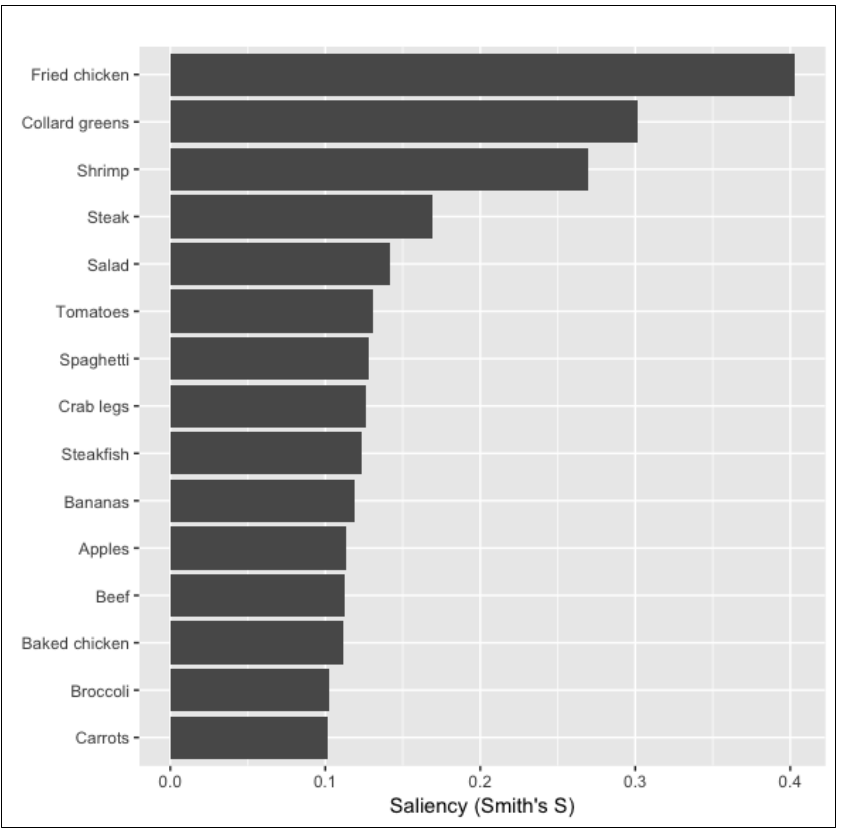
Figure 1. Saliency of Food Items with the Highest Smith’s S Salience Index Scores from Free-listing Activity ( N =20) Figure 1 displays all items with saliency scores above the cutoff point of 0.1 (range: 0.10-0.40). These 15 items were retained for store observation. Since collard greens are often purchased fresh and canned, it was split into two distinct items for store observation, creating a total of 16 observed food